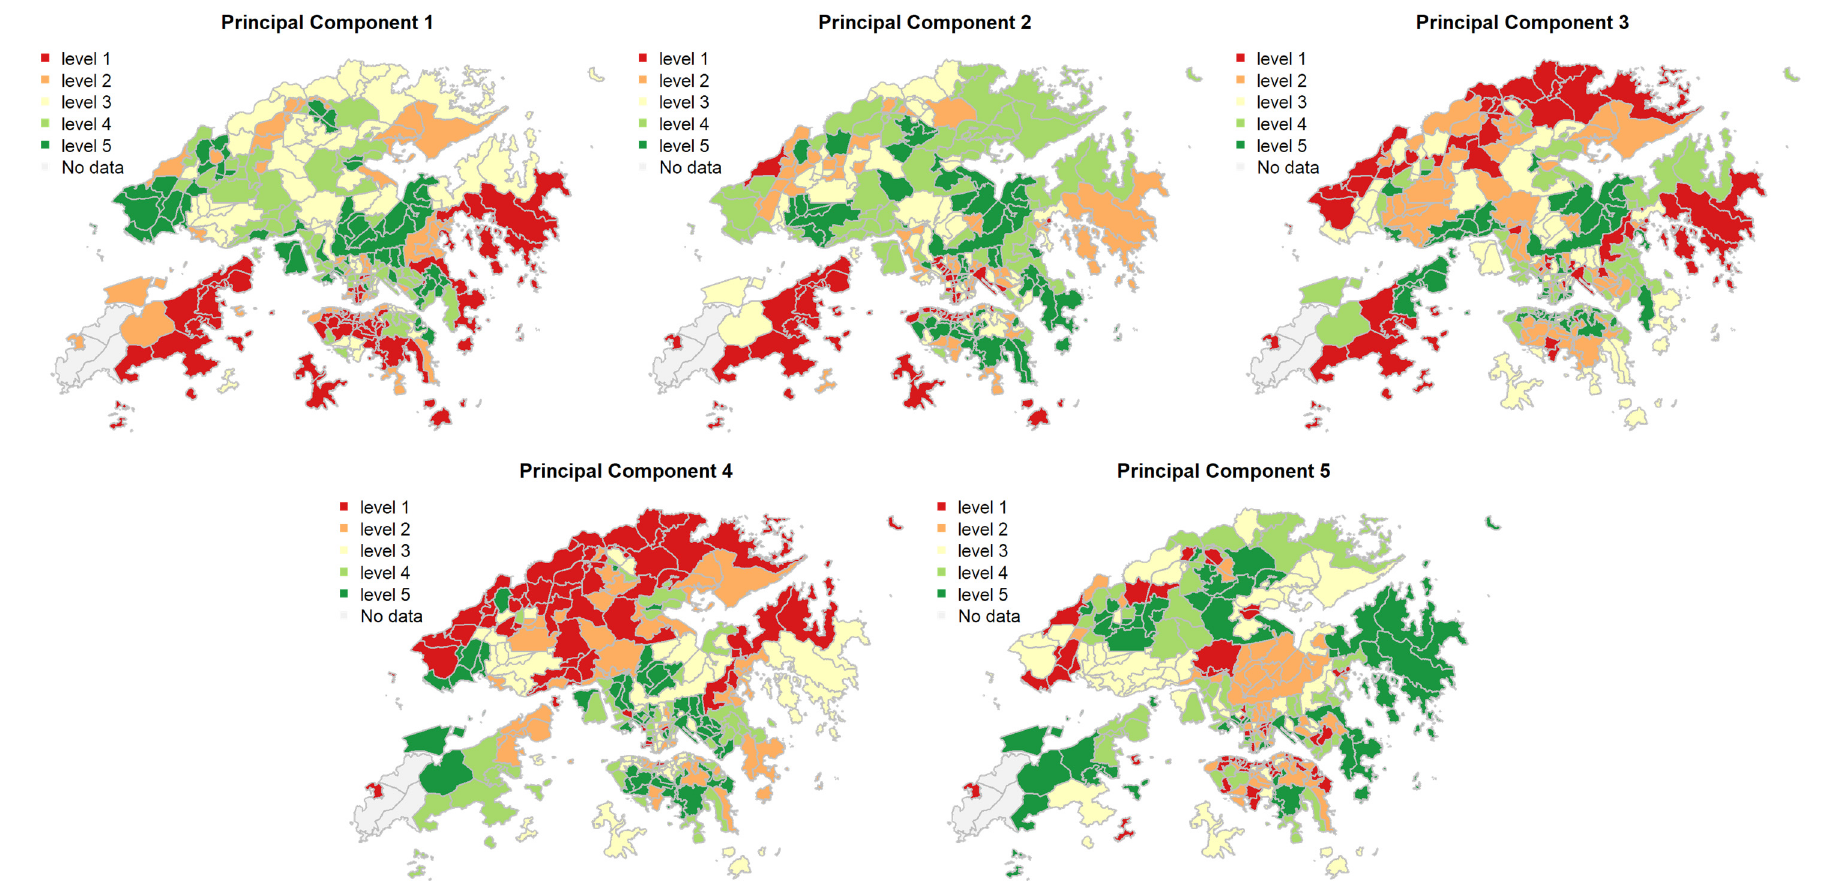
Figure 3. Principal component scores for the five principal components. Note: The five principal components were indigenous degree, family resilience, individual productivity, populous grassroots and young-age respectively. All principal component scores of the TPUs (Tertiary Planning Units) were categorized into five levels using the quantile classification method for data presentation. A five-level scale was selected, as it offers good balance of level differentiation and understandability, and highlights TPUs are in the top and bottom 20%. Higher level indicates higher principal component score.